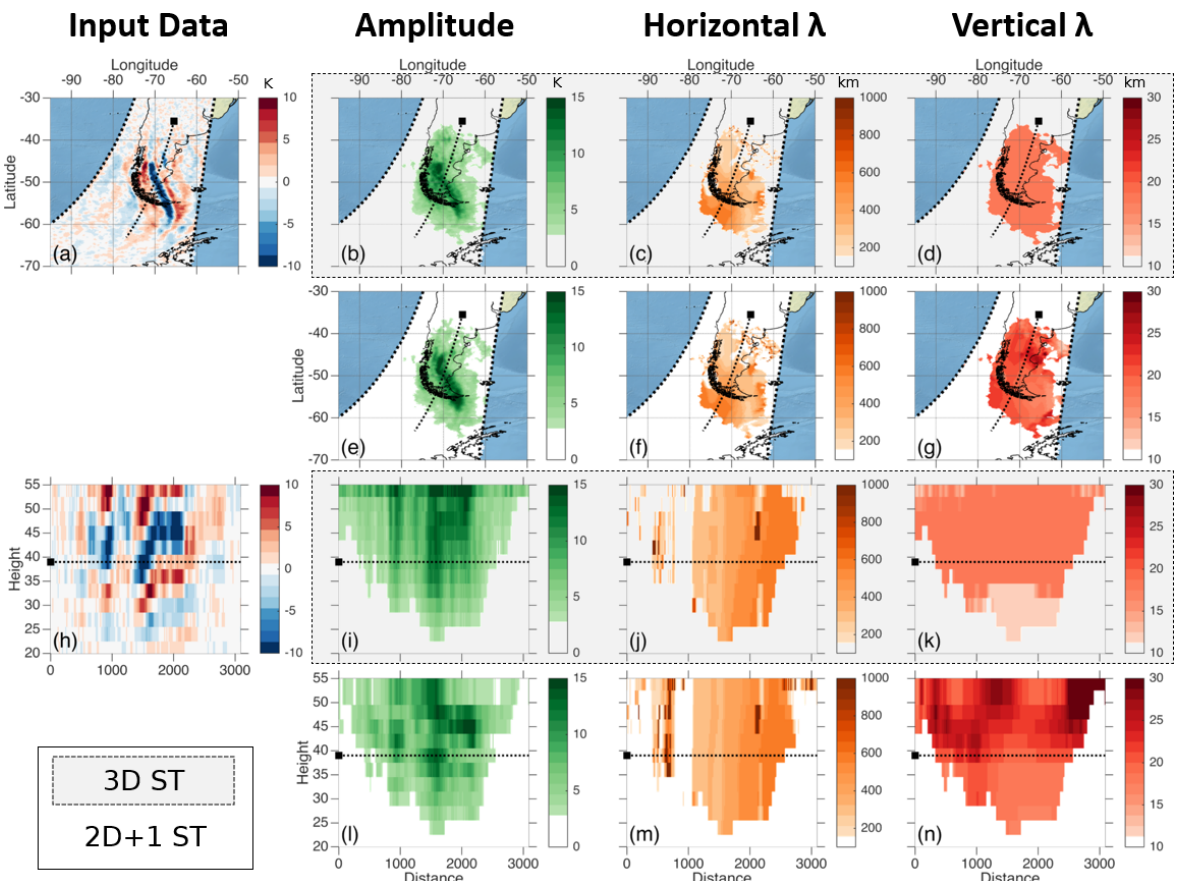
Figure 6. Comparison of 3D ST and 2D + 1 ST estimates of GW parameters for a large orographic gravity wave observed in May 2008 over South America. Panels (a, h) show the original temperature perturbation data as a map at 39km altitude and a vertical cut along the instrument track, respectively; dotted lines show the location of the other set of panels, with a black square indicating zero distance on the lower panel. (b–d, i–k) 3D ST estimates, (e–g, l–n) 2D + 1 ST estimates of (b, e, i, l) wave amplitude, (c, f, j, m) λ h and (d, g, k, n) λ z . Units for each panel are shown above the colour bar at the top of each row. Data have been boxcar smoothed by 5 voxels in each direction in the horizontal plane before plotting to reduce visible noise. Regions with smoothed output amplitudes below 2.7K have been removed from all panels, except (a, h) , to focus on wave features